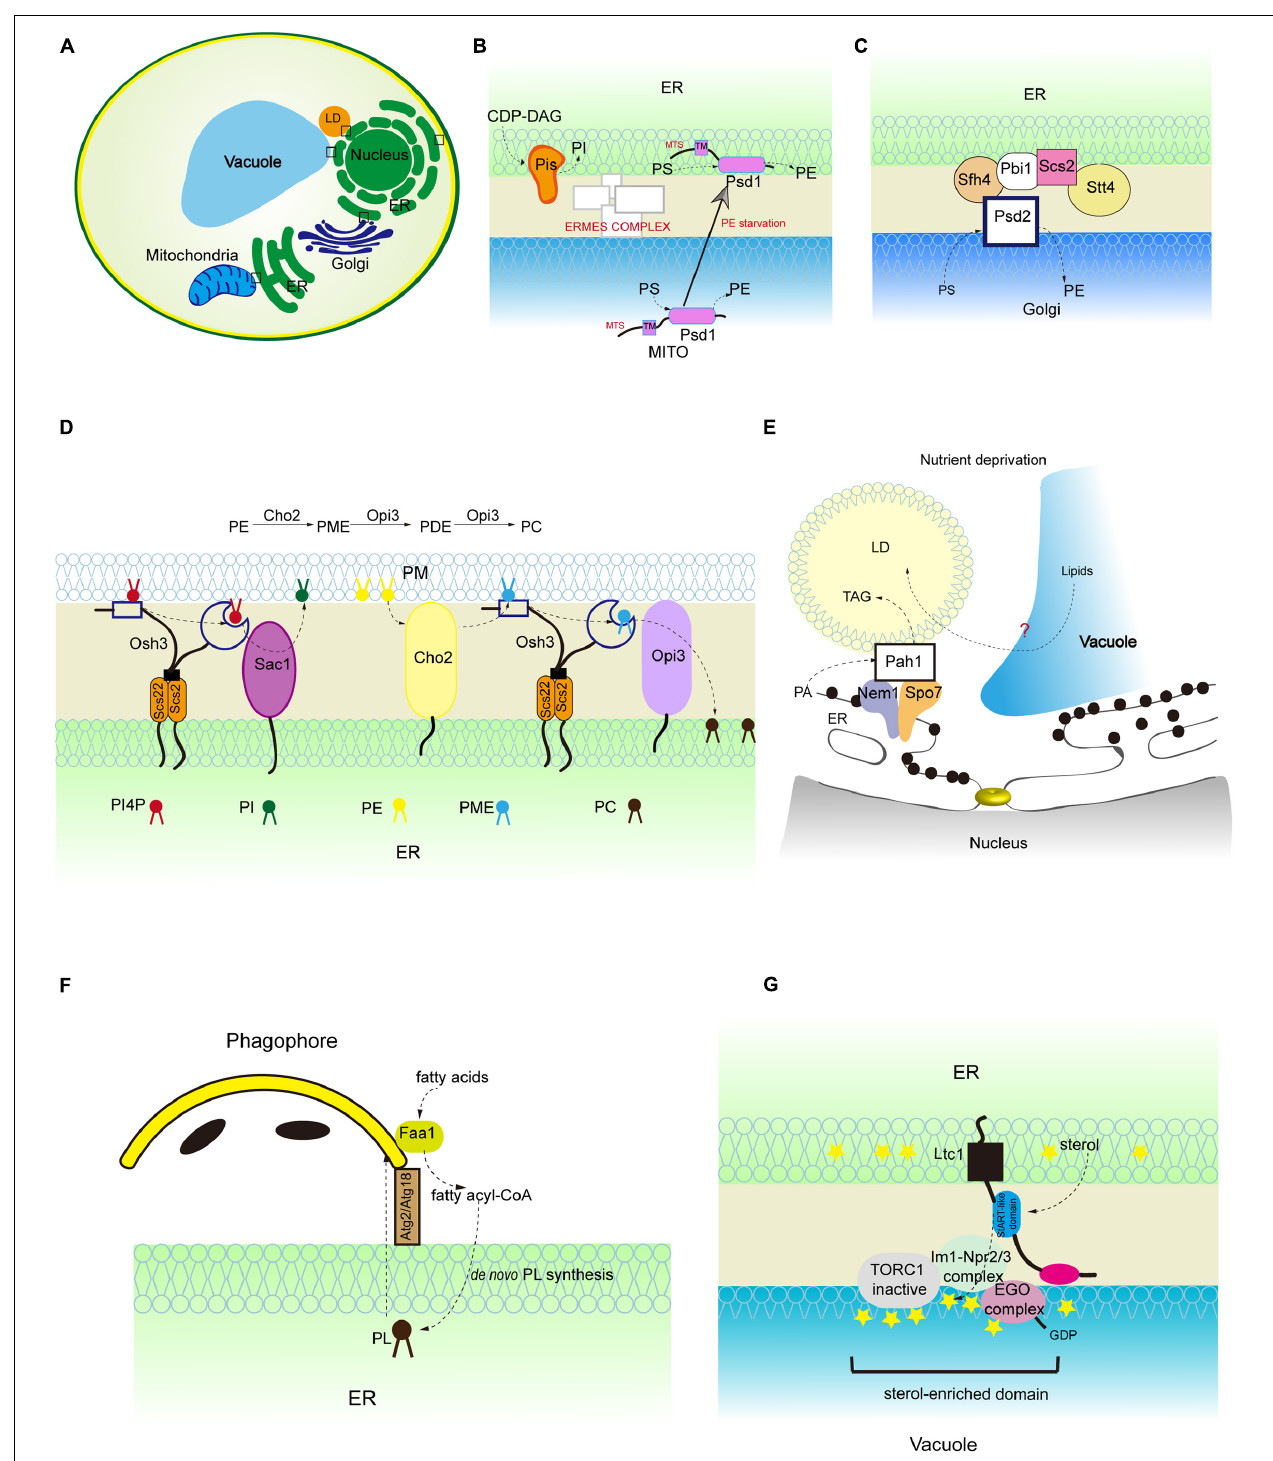
FIGURE 2 | Lipid synthesis and breakdown at MCSs in yeast. (A) Schematic illustration of yeast MCSs. The contact sites discussed in the text are boxed. (B) The mitochondrial and ER fractions of the PS decarboxylase Psd1, PI synthesis from CDP-DAG at MAMs, and PS transporter:ERMES complex. (C) The assembly of ER-Golgi contacts composed of the PS decarboxylase Psd2, Sfh4, the PI4P kinase Stt4, the tether Scs2 that binds Stt4, and Pbi1. (D) PI4P turnover at the ER-PM contact, and PC biosynthesis from PE. (E) LD-associated Pah1 at the nuclear vacuole junction. (F) Local phospholipid synthesis supports phagophore membrane expansion from the ER. (G) Concentration of the positive regulator of Torc1 (Ego complex) into sterol-enriched domains at ER-vacuole contacts. PME, phosphatidylmonomethylethanolamine; PDE, phosphatidyldimethylethanolamine.